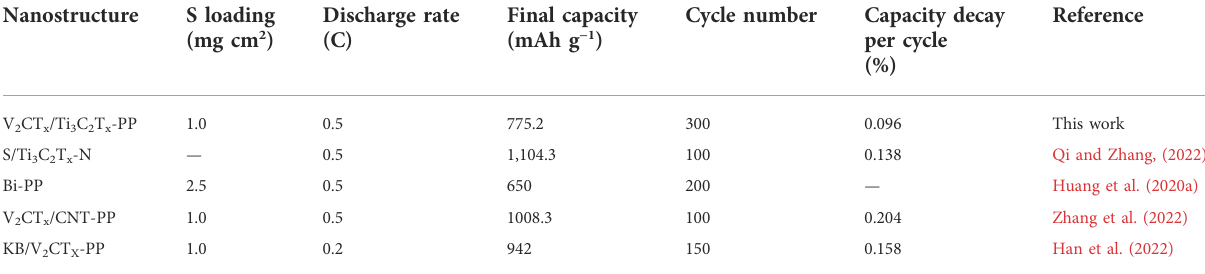
TABLE 1 Comparison of the electrochemical performance between this work and other previously reported